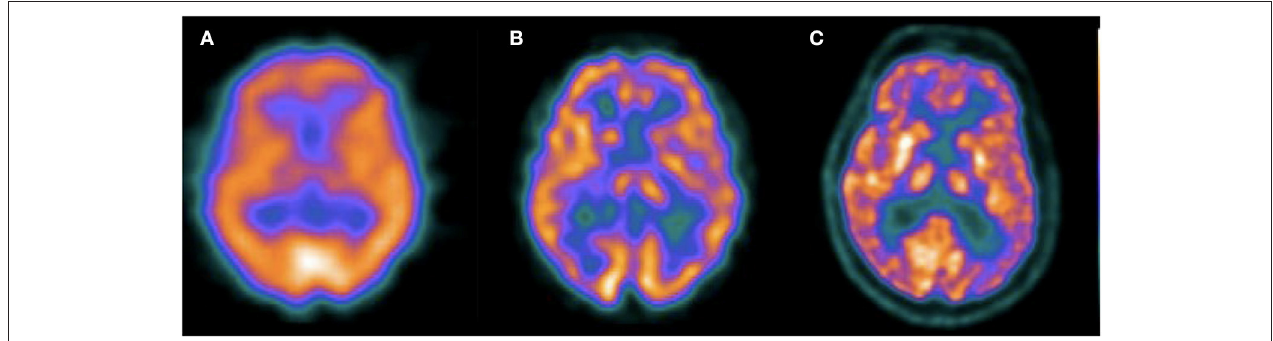
FIGURE 3 | Transaxial slices of perfusion SPECT and 18 F-FDG PET of different patients. The first image (A) corresponds to a perfusion SPECT acquired in a single head gamma camera in 1998 (Sopha DSX rectangular). The second image (B) corresponds to a perfusion SPECT with the same radiotracer ( 99m Tc-ECD) acquired in 2009 in a two headed gamma camera, without scatter correction (Mediso Nucline SPIRIT DH-V). The third image (C) corresponds to a 18 F-FDG PET acquired in 2015 (GE Discovery STE). This figure illustrates the significant advances of SPECT image quality in recent years and the comparison with typical 18 F-FDG images.